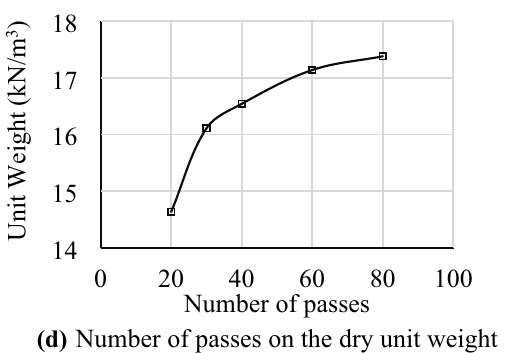
Fig. 10 Experimental test setup ( a ) compaction tool for soil in the sandbox, ( b ) and ( c ) instrumentation inside soil and footing steel reinforcement, and ( d ) number of passes for soil